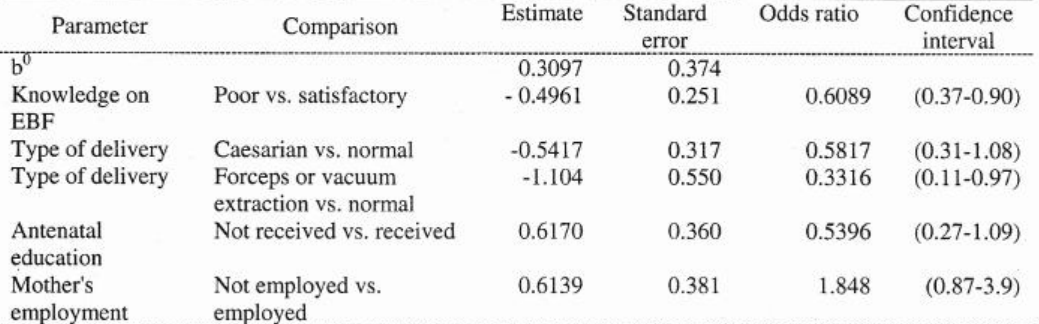
Table 3 . Variations associated with exclusive breast feeding - results ofthe logistic regression